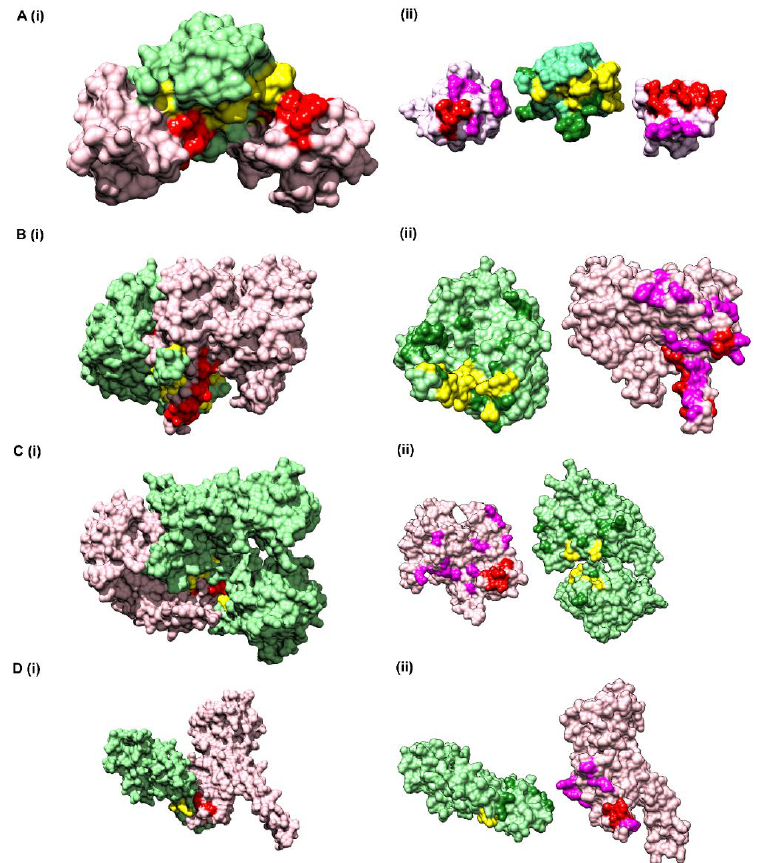
Figure S5B. The inter-protein contact forming residue pair network of Chain A and Chain C as obtained from Random Forest classifier is shown in Figure S5C which consisted to 992 predicted pairs of which 967 were false positives. A residual network was calculated from the three networks mentioned above (as shown in Figure S5D) and the final pairs were plotted as a matrix of Protein A versus Protein B. Since a 5 × 5 matrix was used to derive the environmental features, a unitary matrix of 5 × 5 was convolved onto the resultant interface prediction matrix. Pairs having convolved value more than 6 were selected, which reduced the total pairs to 359 of which 42 were true positives and 317 were false positives. The results obtained from the pipeline are shown onto the structure of Vav and Grb2 Sh3 domains (PDB ID 1GCQ) (Figure 5A(i)). Interestingly, the data labels provided while testing was only for Chain A and Chain C but the labels obtained after prediction were for both the pairs, i.e., Chain A and Chain C, as well as Chain B and Chain C (Table S6), within 10 Å distance. In comparison to the interface predicted by PISA using the structural information, CoRNeA was able to predict at least 50% of true pairs as depicted in Figure 5A(ii). Thus, the overall pipeline to predict the PPI interface is fair in predicting the probable pairs of interacting residues, as well as to separate out the residue which might reside on the surface of the protein from those present in the core of the individual proteins only from amino acid sequence information. The confusion matrix before and after the network analysis for all the test datasets is provided in Table 3. Biomolecules 2020 , 9 , x